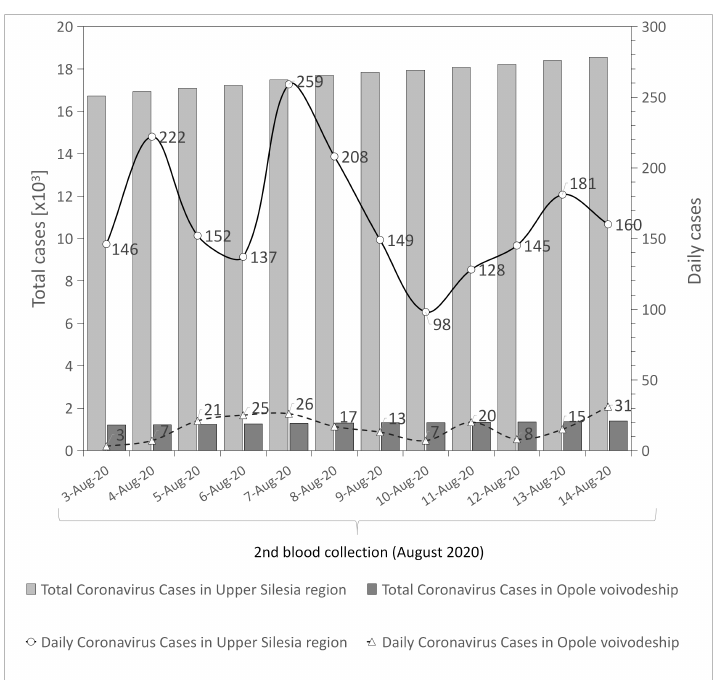
Figure 3. Number of infected individuals in both regions during 2nd blood collection ( n II , August 2020)